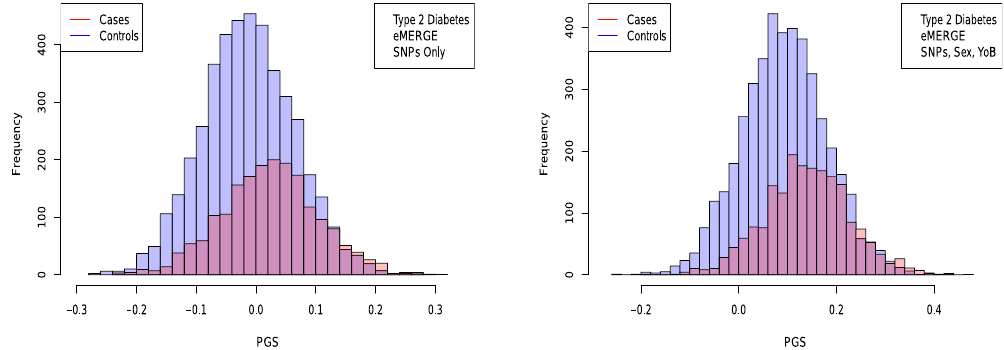
Figure 8. Distribution of PGS score, cases and controls for type 2 diabetes in the eMERGE dataset using SNPs alone and including sex and age as regressors.